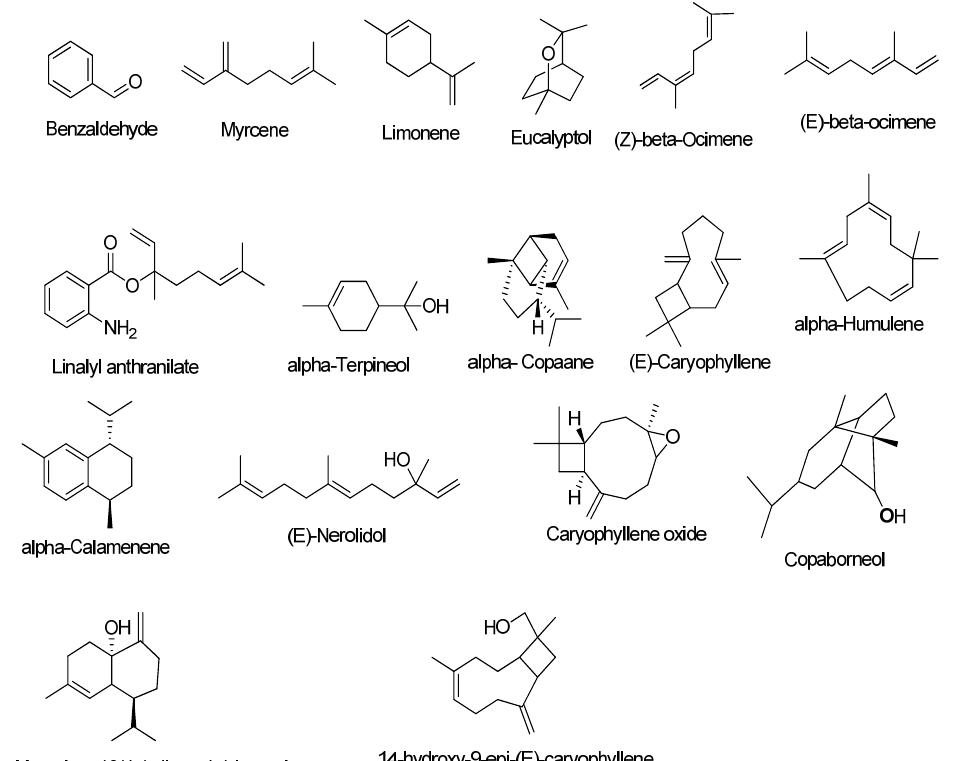
Figure 2. The structure of the compounds obtained after GC–MS analysis. The common name of each compound is given below each compound.